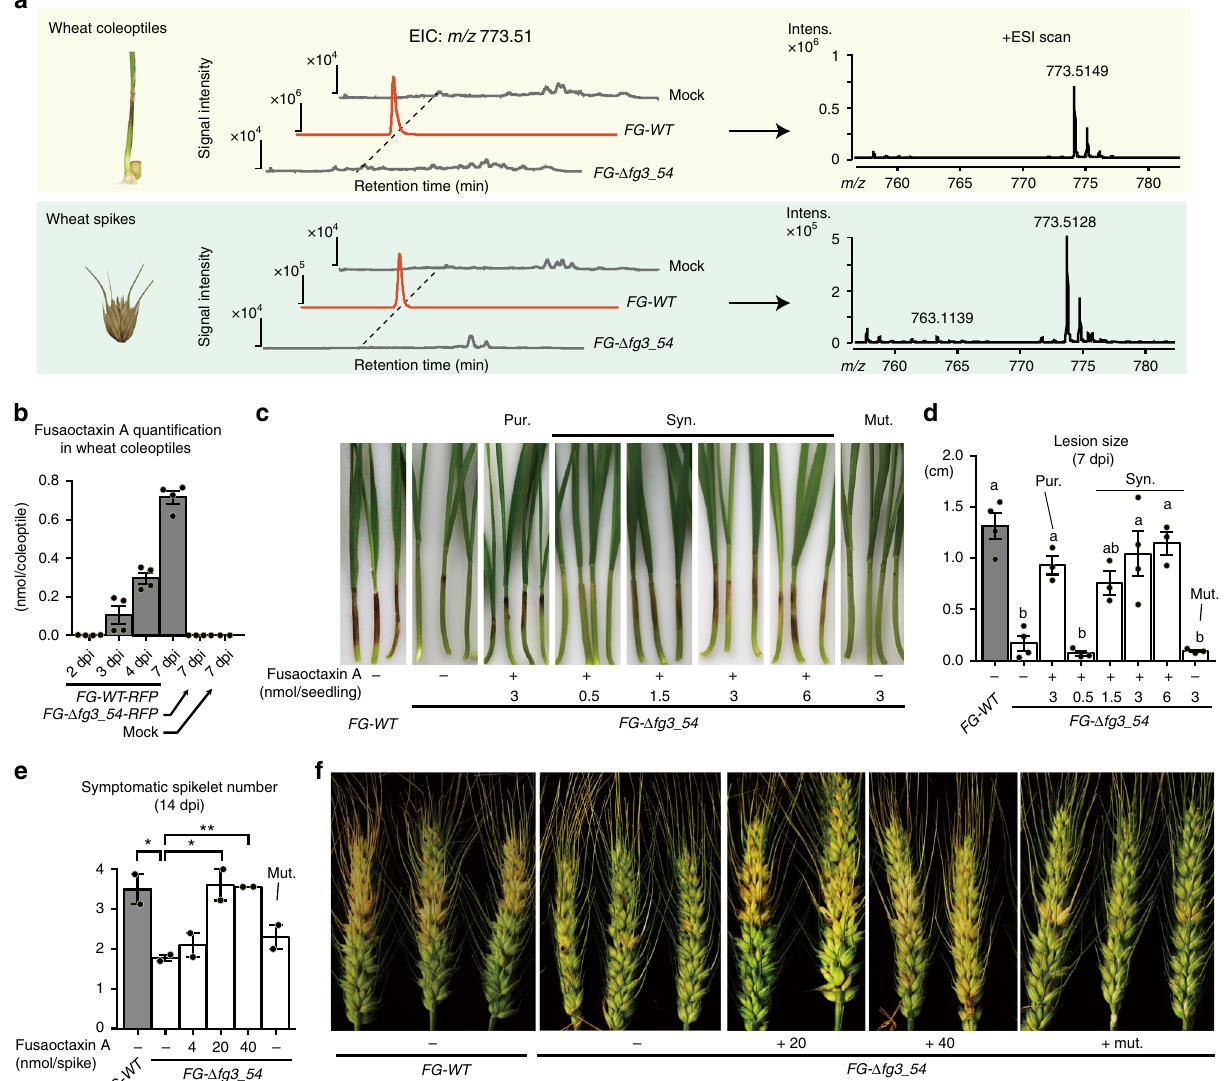
Fig. 5 Detection of endogenous fusaoctaxin A in infected wheat tissues and infection complementation by exogenous fusaoctaxin A. a Extracts analysis of wheat coleoptiles and spikes infected by F. graminearum at 7 dpi using LC-ESI-MS. The extracted ion chromatography (EIC) of 773.51 (left) and mass spectrum (right) of the samples are shown. The experiments were repeated three times, and the results of one representative experiment are shown. b Quanti fi cation of endogenous fusaoctaxin A in infected wheat coleoptiles using LC – MS/MS. c , d Representative images and measurements of lesions on wheat seedling coleoptiles infected by indicated F. graminearum strains at 7 dpi. pur.: puri fi ed fusaoctaxin A from fungal extracts; syn.: Arti fi cial synthesized fusaoctaxin A; mut: chemically synthesized control peptide GIAVSTAG. Different letters indicate a signi fi cant difference ( P < 0.05) based on one-way ANOVA followed by Tukey ’ s multiple comparison test ( F = 16.17 df = 7, P < 0.0001). e , f The number of symptomatic spikelets and symptoms of wheat spikes infected by indicated F. graminearum strains at 14 dpi. Data are means ± s.e.m. Asterisks indicate a signi fi cant difference ( P < 0.05) compared with FG- Δ fg3_54 according to the two-tailed unpaired Student ’ s t -test (* P < 0.05; ** P < 0.01). Source data are provided in Supplementary Data